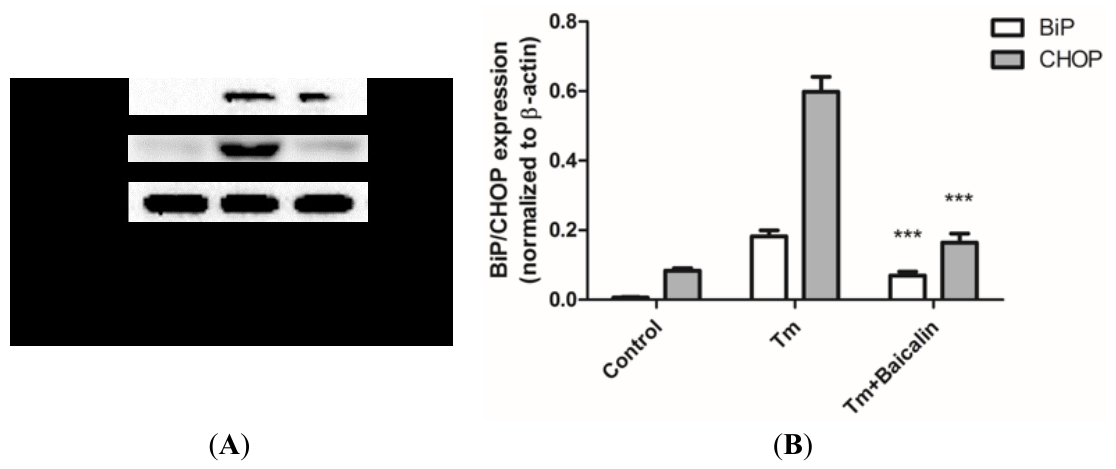
Figure 5. The effects of Baicalin on ER stress hallmarks in cultured HK-2 cells after tunicamycin treatment. HK-2 cells were treated with 2.5 μg/mL tunicamycin for 24 h. Tunicamycin treatment increased expression of BiP and CHOP ( A ); indicating the up-regulation of ER stress ( B ). Baicalin pretreatment significantly